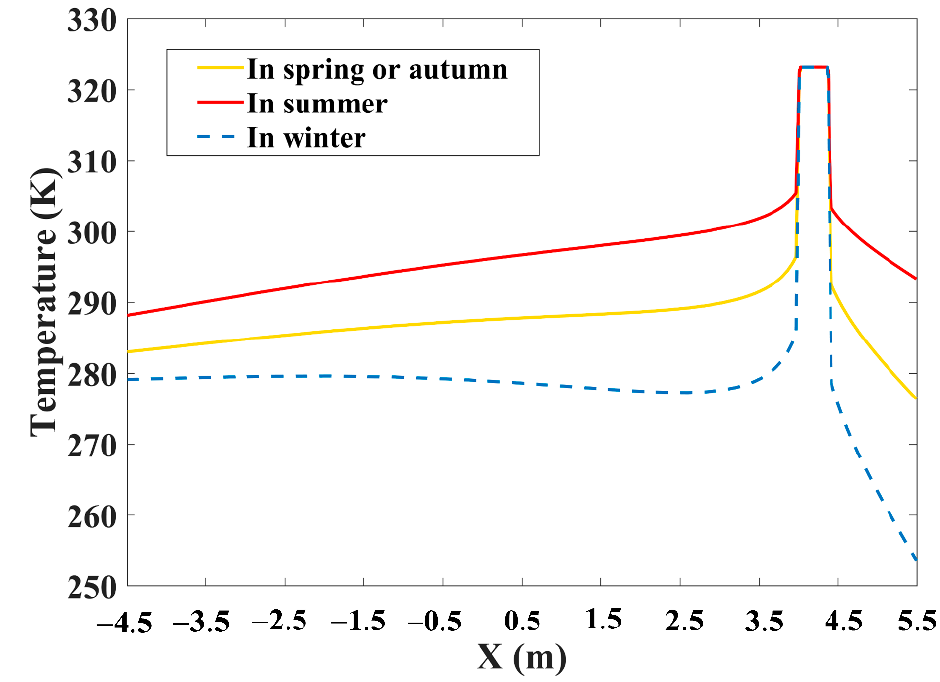
Figure 16. Temperature distribution along the centerline in different seasons.